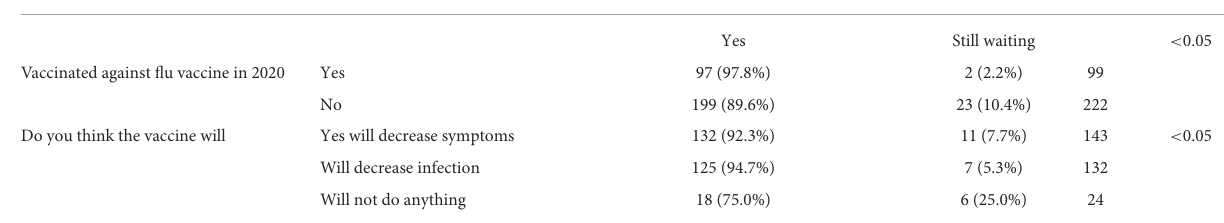
TABLE 3 Association between patients who got the first dose of COVID-19 vaccine and who got the flu vaccine and their opinion on the effectiveness of the COVID-19